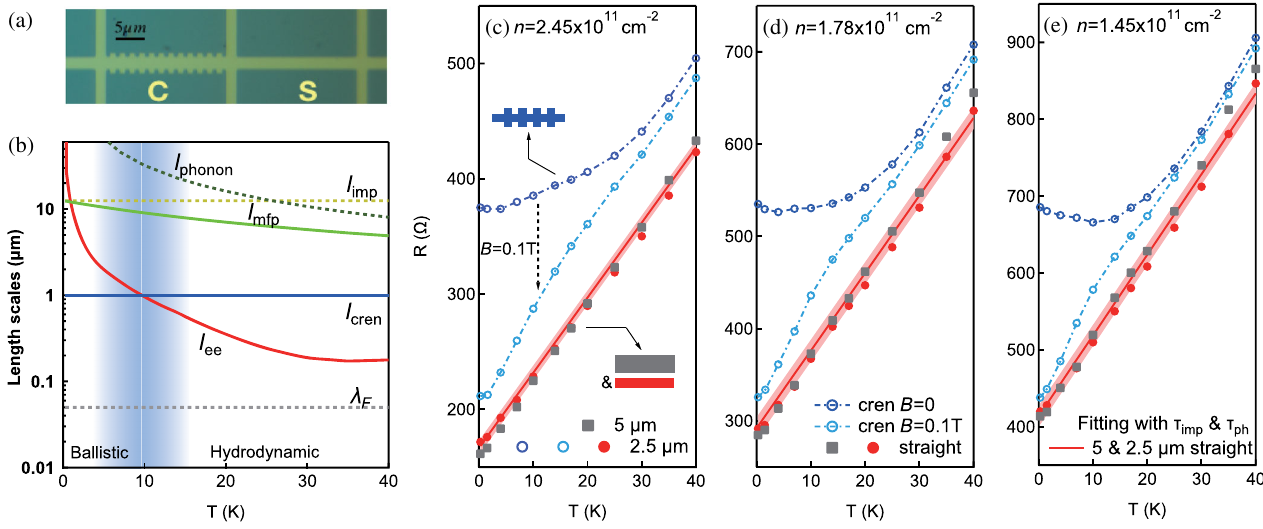
FIG. 2. (a) Image of the accumulation-mode GaAs heterostructure device containing a high-mobility 2DEG. The gate-defined channel contains two sections: a 2 . 5 - μ m-wide and 25 - μ m-long straight channel labeled “ S ” and a crenellated channel “ C ” of the same ¼ 1 μ m. (b) Key length scales and transport regimes in the system at n ¼ 2 . 45 × 10 11 cm − 2 . l dimensions with crenellations of l cren mfp is the momentum-relaxing mean free path due to electron-phonon ( l ) and electron-impurity ( l ) scattering. l is the size and phonon imp cren is the Fermi wavelength. l is the theoretically calculated electron-electron scattering length. The spacing of the square crenellations. λ F ee shaded blue area indicates the gradual crossover from hydrodynamic to ballistic transport regimes around T ∼ 10 K as the smallest length scale in the system varies between l and l . (c),(d) Experimentally measured resistance of both straight and crenellated ee cren channels R and R , respectively, as a function of the temperature for three electron densities n ¼ 2 . 45 , 1.78, and straight cren 1 . 45 × 10 11 cm − 2 , respectively. The resistances of two straight channels with different widths W ¼ 2 . 5 and 5 μ m but the same length-to-width ratio are shown by the red solid circles and gray squares and are indistinguishable. The solid red lines are fits to R straight including both electron-impurity and electron-phonon scattering with the shaded area presenting the uncertainty. The resistance of the crenellated channel C is shown both at B ¼ 0 (dark blue empty circles) and with a small out-of-plane magnetic field B ¼ 0 . 1 T (light blue empty